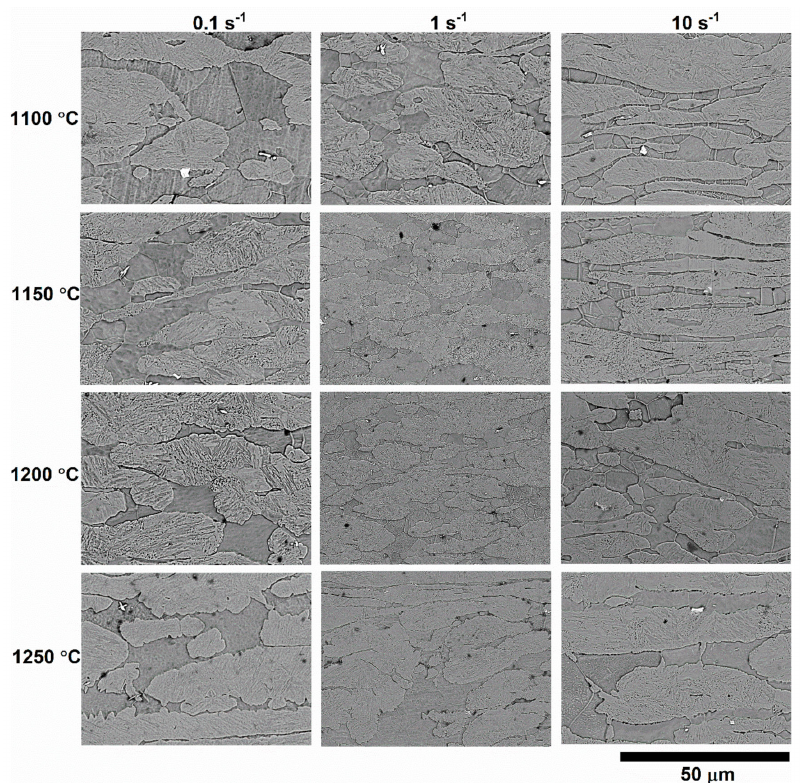
Figure 4. Microstructure of 13CrMoNbV steel after hot deformation at di ff erent temperatures and strain